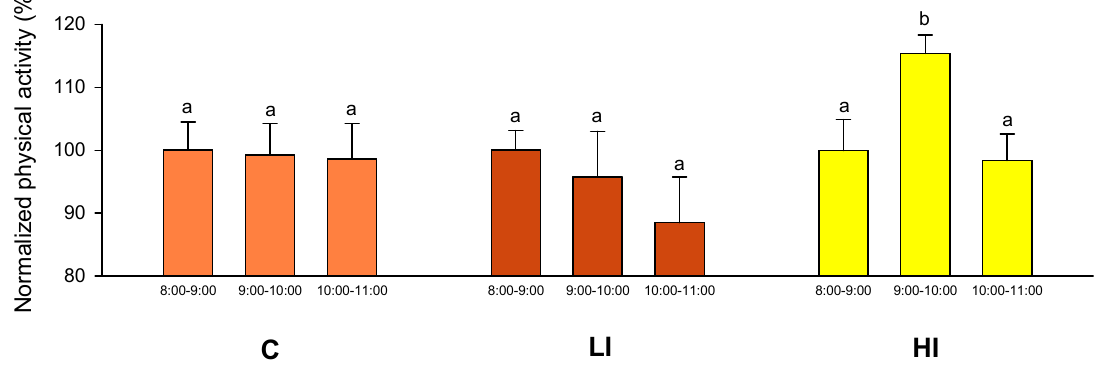
Figure 3. AEFishBIT records (D1) of reaction to change in light regime. Light was changed at 9:00 h (D1) in the LI (red bars) and HI (yellow bars) groups, whereas it remained unchanged for the C (orange bars) group. For each experimental group, physical activity is referred as a percentage of measured values in the 8:00–9:00 h period (before light change). Each value is the mean ± SEM of 6–7 individuals. Different letters indicate significant differences ( p < 0.05, one-way ANOVA followed by Holm–Sidak test).